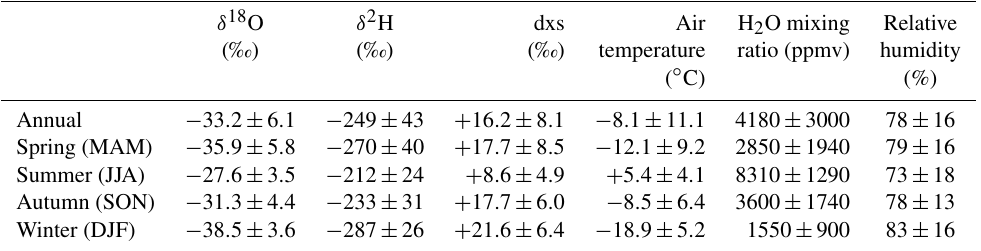
Table 1. Annual and seasonal mean ± 1 standard deviation (SD) values of selected water vapor isotopic and meteorological variables for Thule, Greenland, over the analytical period of this study. Values are calculated using 10min resolution data.